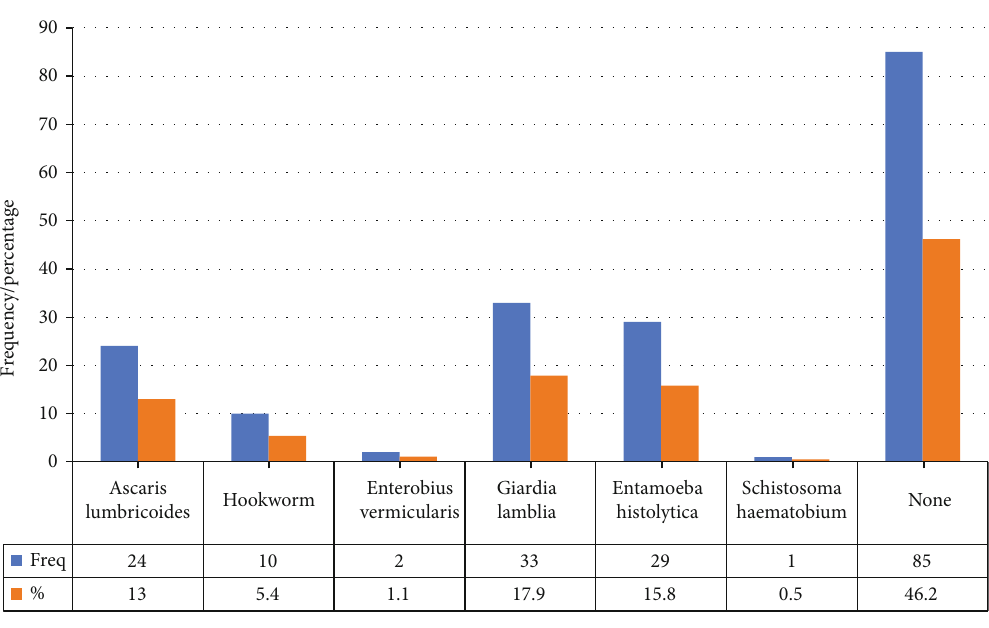
Figure 1: Intestinal parasites seen by